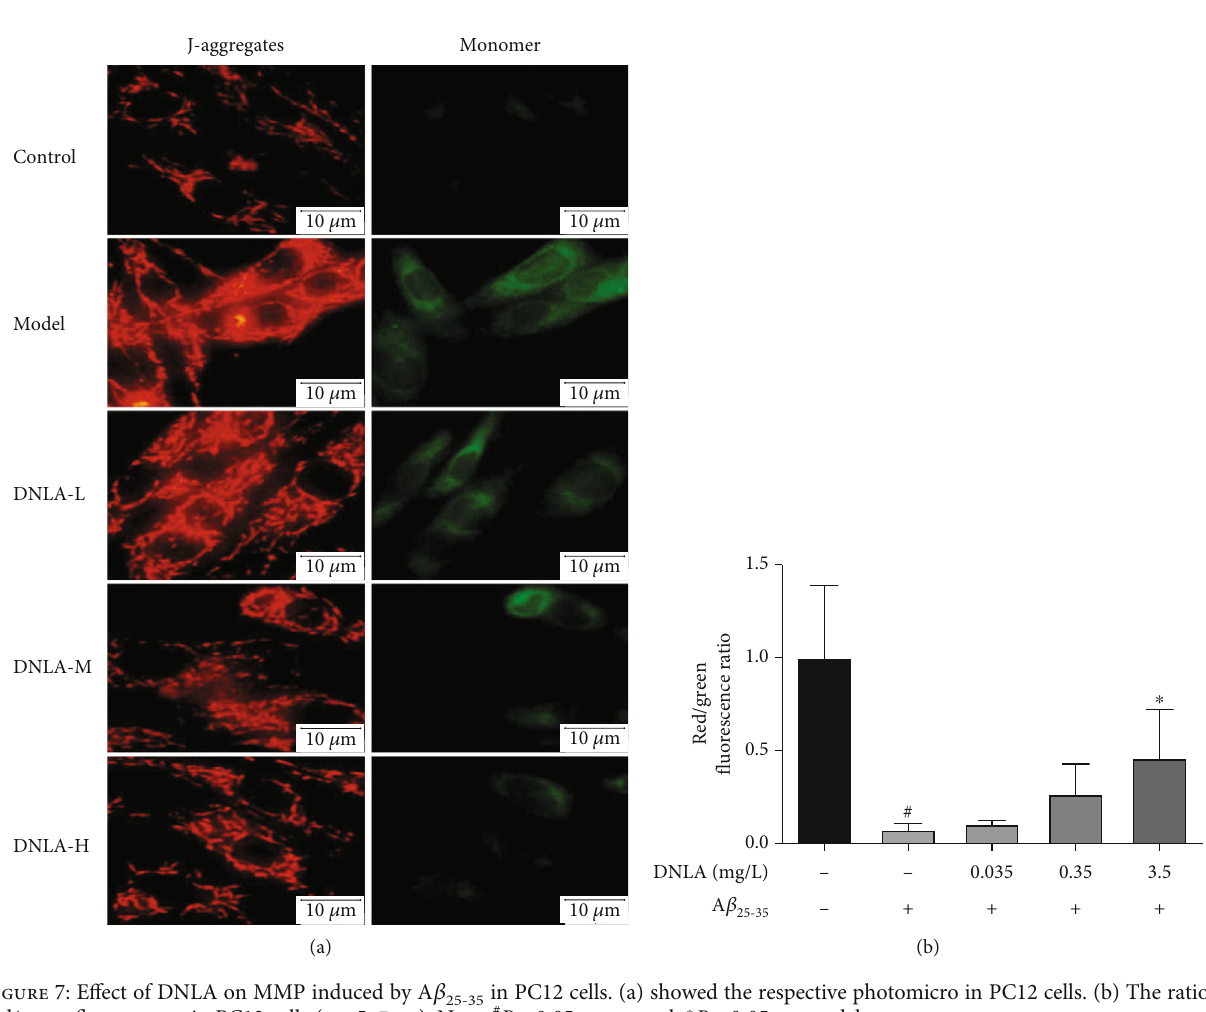
Figure 6: E ff ect of DNLA on the expression of Bax and Bcl-2 induced by A β induced mitochondrial apoptosis pathway proteins. (b) The ratio of Bax/Bcl-2 in PC12 cells ( n = 3 , (cid:1) x ± s ). Note: # P < 0 : 05 vs. control; ∗ P < 0 : 05 vs. model.